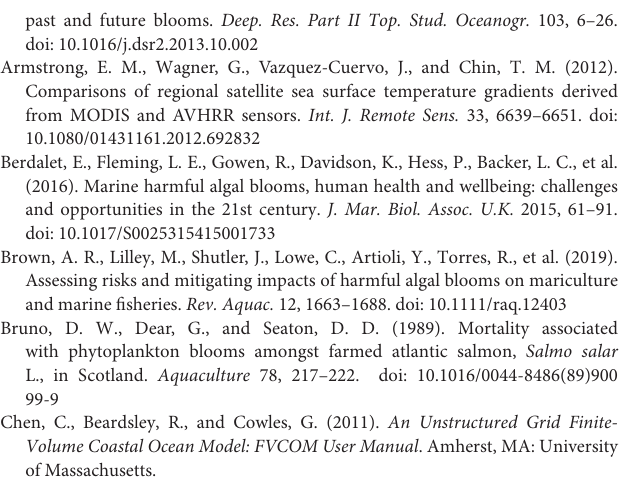
Supplementary Figure 2 | The paths of drifters released to the west of Shetland in September 2015. Black shows 15-m-drogued SVP-style drifters. Magenta shows surface CODE-style drifters. Supplementary Figure 3 | Daily tracks of the observed (red) and virtual (blue) drifters seeded into (a) the surface and (b) 15 m depth at the times and locations of observed drifters. Virtual drifters were advected by currents derived from the daily-averaged Mercator-IBI36 model velocity field. Supplementary Figure 4 | This figure displays the various panels referred to in the case study (see section “Case Study: Combining Data Sources and Expert Interpretation to Forecast Risk”). Panel (A) shows chlorophyll concentrations observed around Shetland on the 21st June 2020, data courtesy the CMEMS (marine.copernicus.eu) portal. Panel (B) shows forecasted sea surface currents for the 23rd June 2020. Data courtesy Mercator-IBI36 model (Sotillo et al., 2015). Panel (C) shows a magnified section of panel (B) . Panel (D) shows a wind rose of wind directions and wind speeds around the Shetland Islands during week 26. Panel (E) illustrates sea surface temperatures around the Shetland Islands on the 22nd of June, data courtesy Multi-Satellite aggregated MUR-SST 1 km gridded dataset, JPL, NASA (Armstrong et al., 2012). Panel (F) is a map of Shetland with the concentrations of observed Pseudo-nitzschia in actively monitored shellfish harvesting sites indicated by yellow and red dots. Yellow dots indicate locations where low concentrations were found whereas red dots indicate locations where concentrations were in excess of official control monitoring trigger